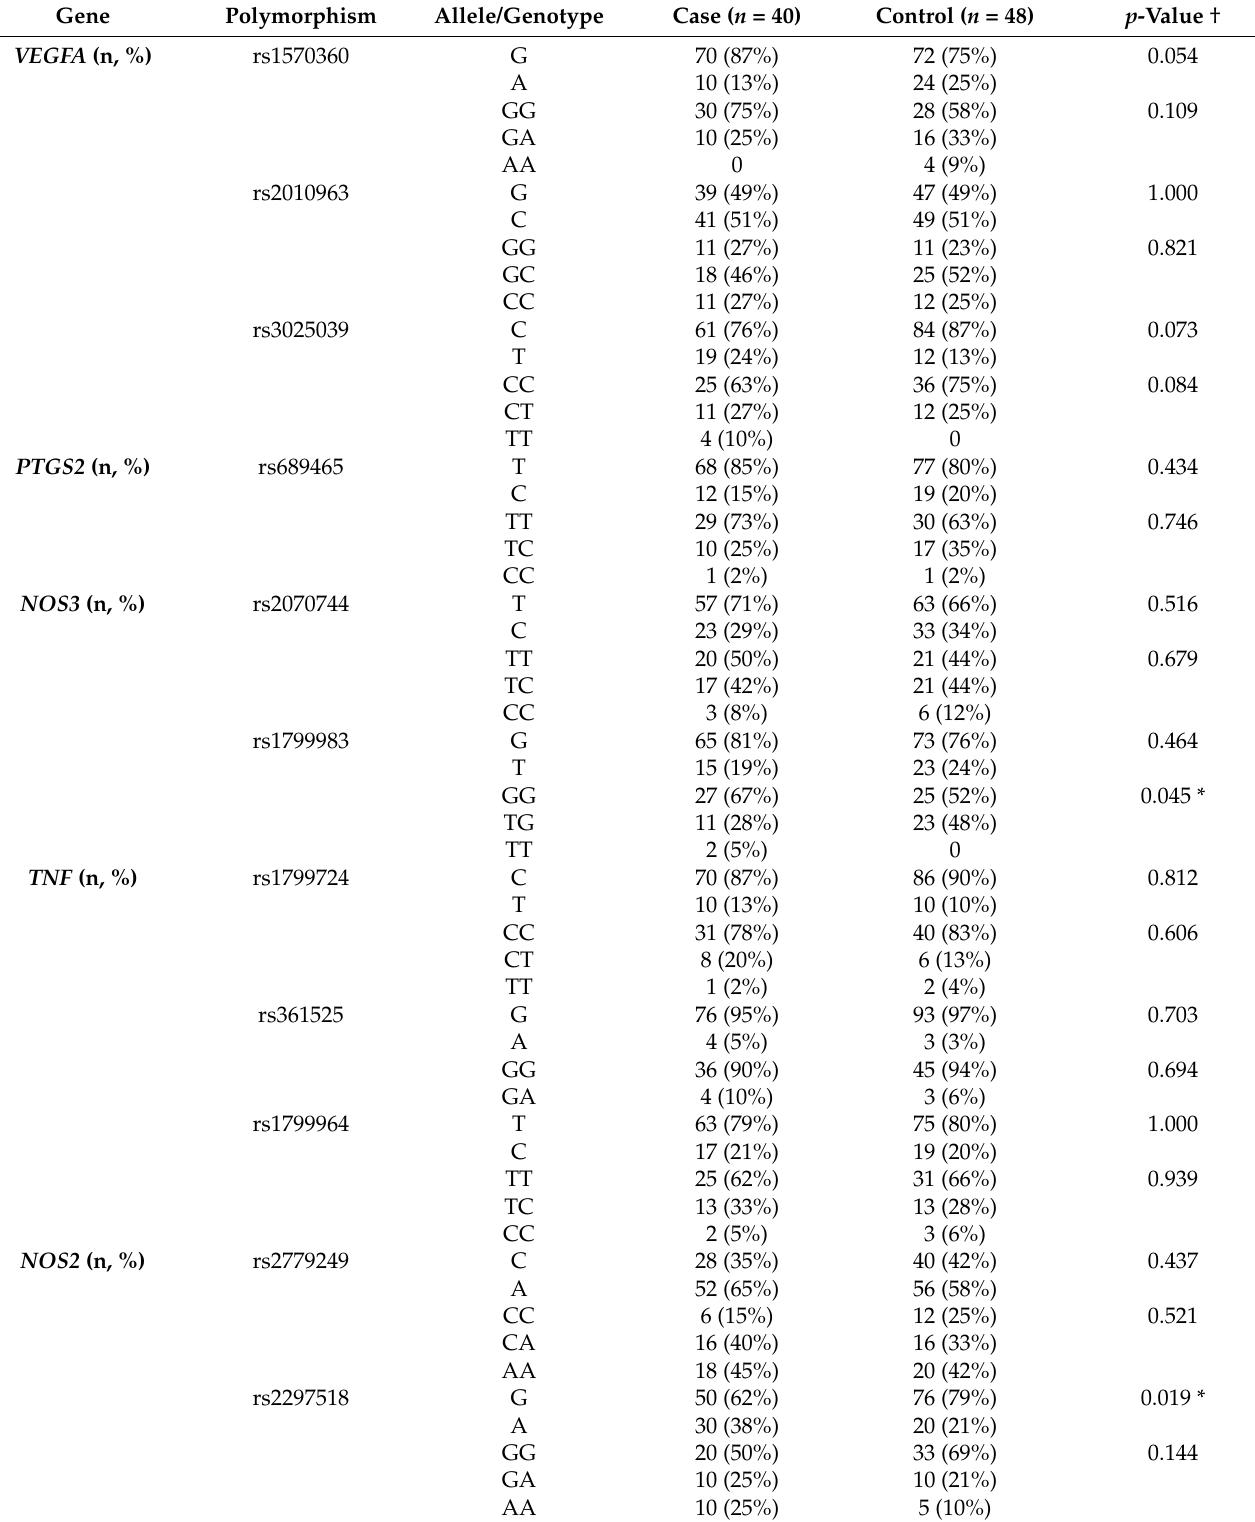
Table 2. Allelic and genotypic frequencies of polymorphisms in VEGFA, PTGS2, NOS3, TNF, and NOS2 genes in the case and control